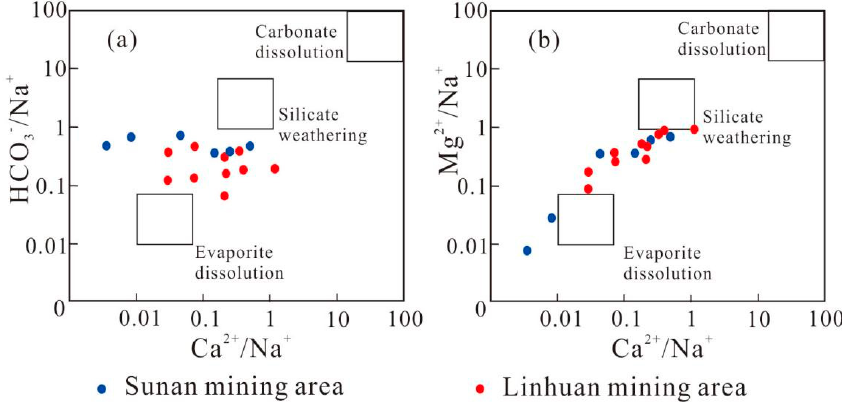
Figure 7. Diagram of ion combination ratio of the Taiyuan formation limestone water in the study area.